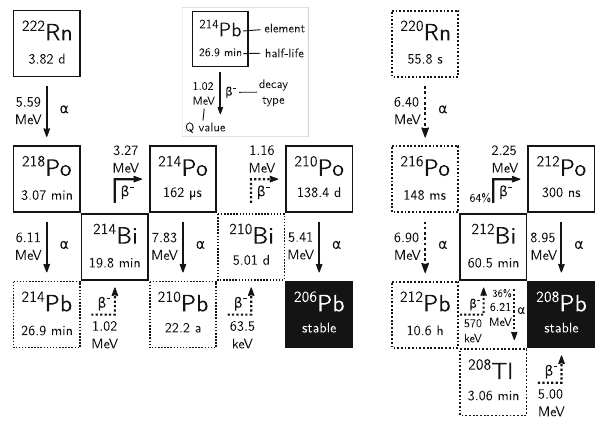
Fig. 1 Illustrations of the 222 Rn (radon) and 220 Rn (thoron) chains (ignoring decay modes with a branching ratio ≤ 0 . 1%). Half-lives, branching ratios and Q -values are taken from [11]. Solid boxes mark the isotopes that are quantified in this